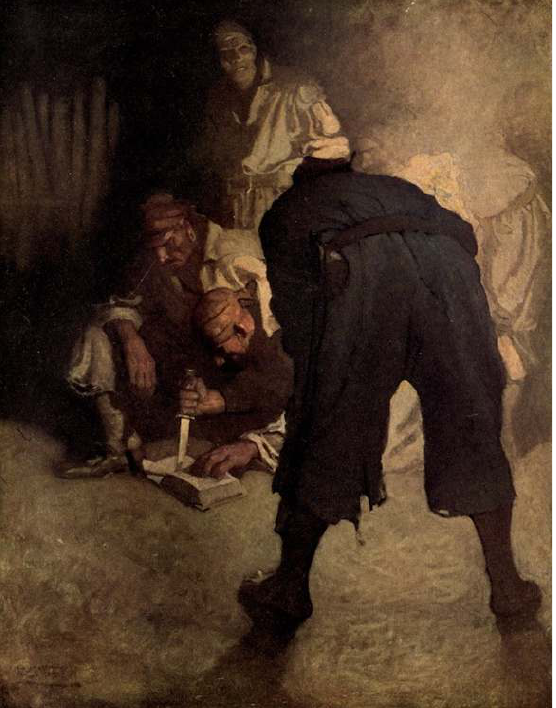
Figure 6. N. C. Wyeth, The Black